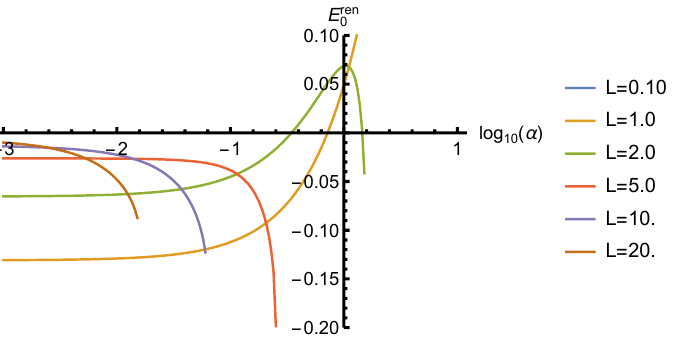
Figure 4. The vacuum energy E ren of a massless scalar field in a box with attractive self-interaction 0 and µ = 1. The curves terminate when the energy becomes complex. E ren and α are given in units of µ 0